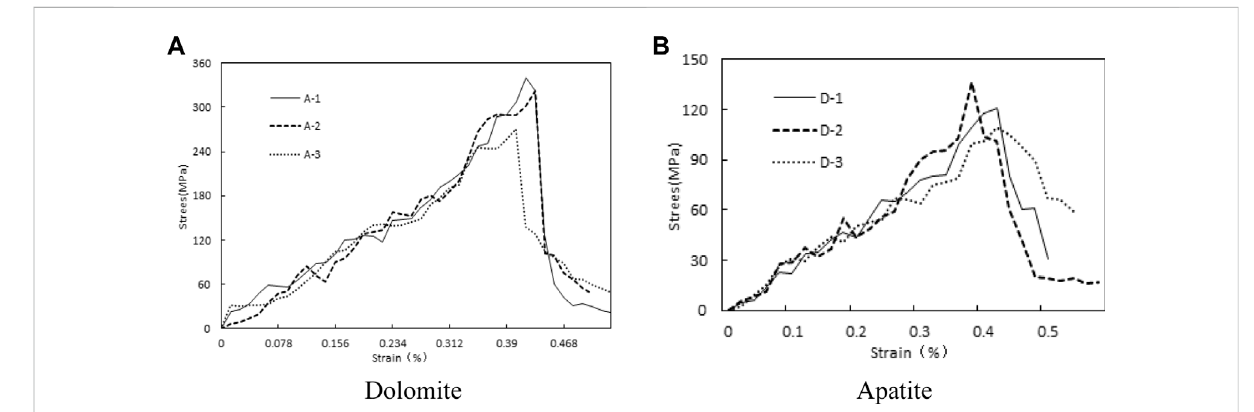
FIGURE 5 The response curves of the rock-forming minerals from mechanical testing. (A) Dolomite (B)